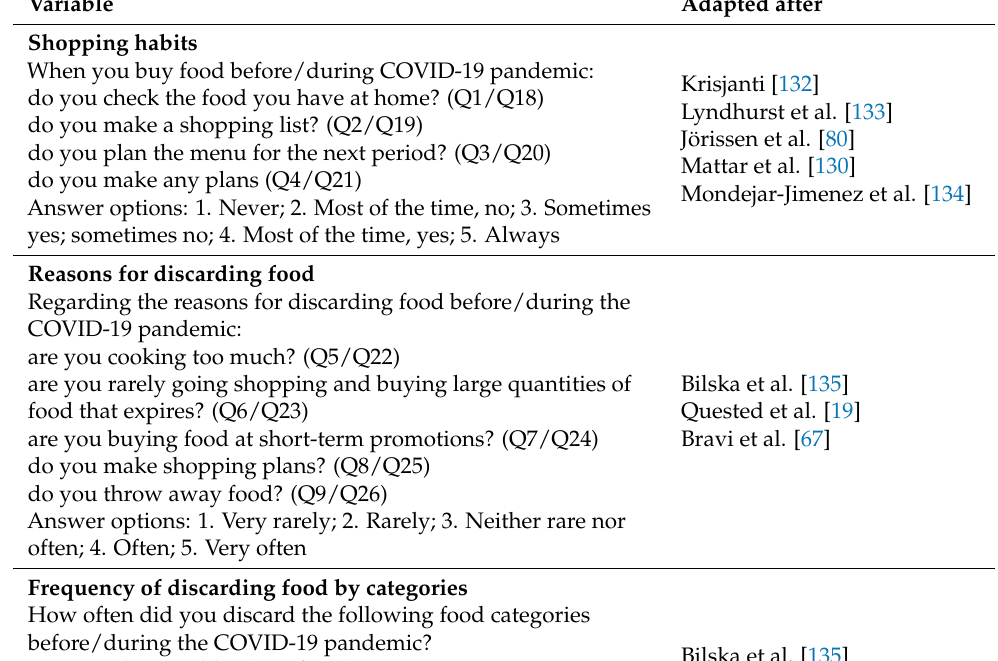
Table 1. Categories of collected data.